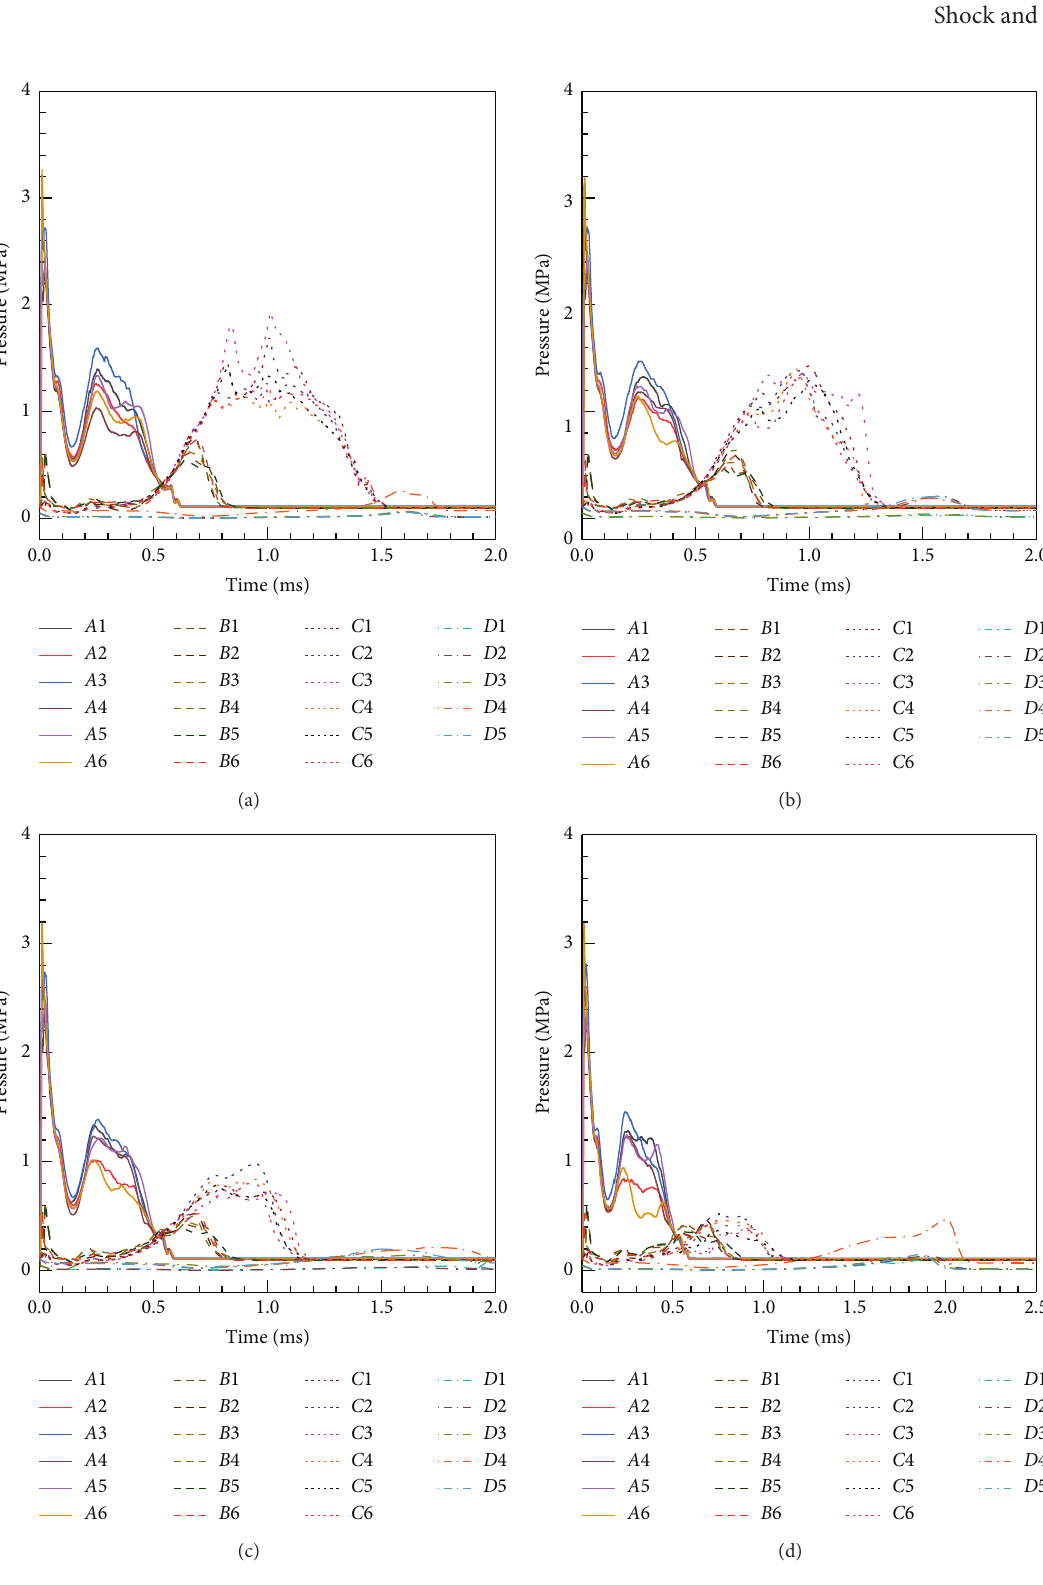
Figure 12: Pressure of different points under different cases: (a) case 1, (b) case 4, (c) case 5, and (d) case